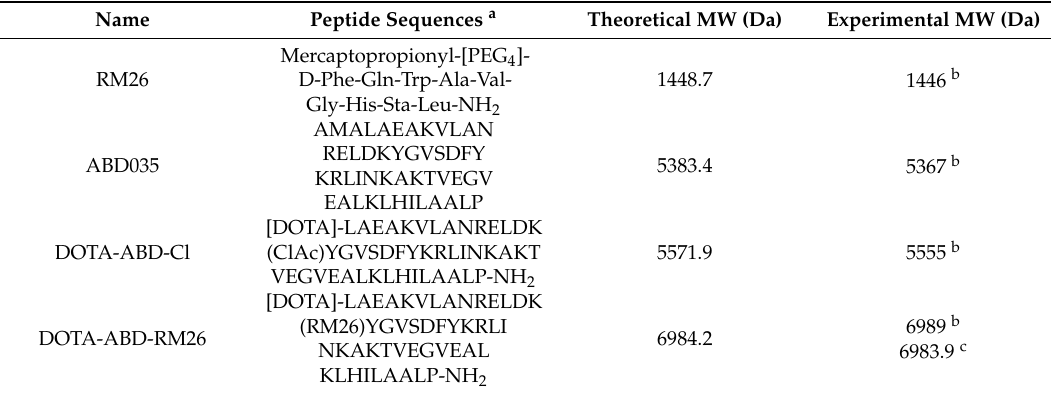
Table 1. Peptides and proteins used in the study.